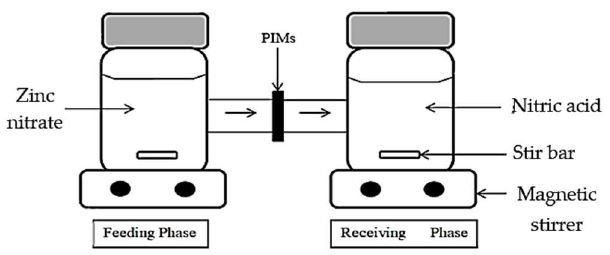
Figure 1. The H-cell device setup.